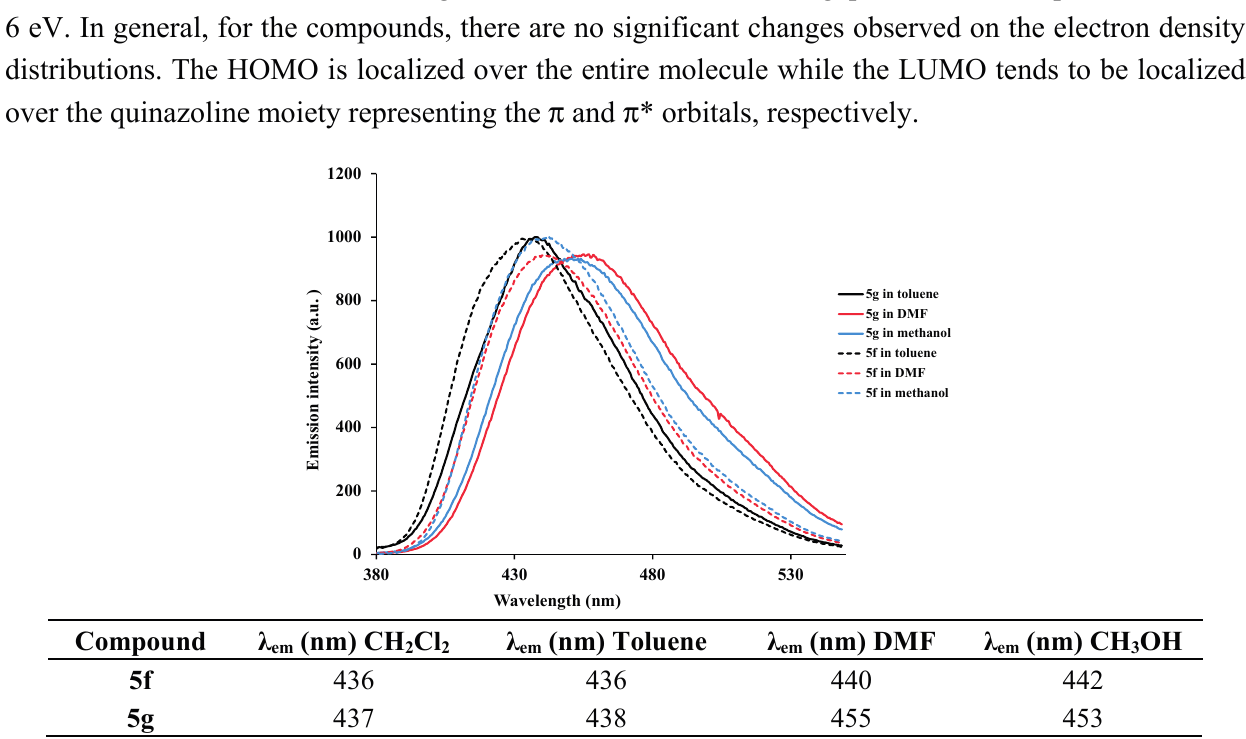
Figure 5. Emission of compounds 5g and 5f in solvent of different polarity.